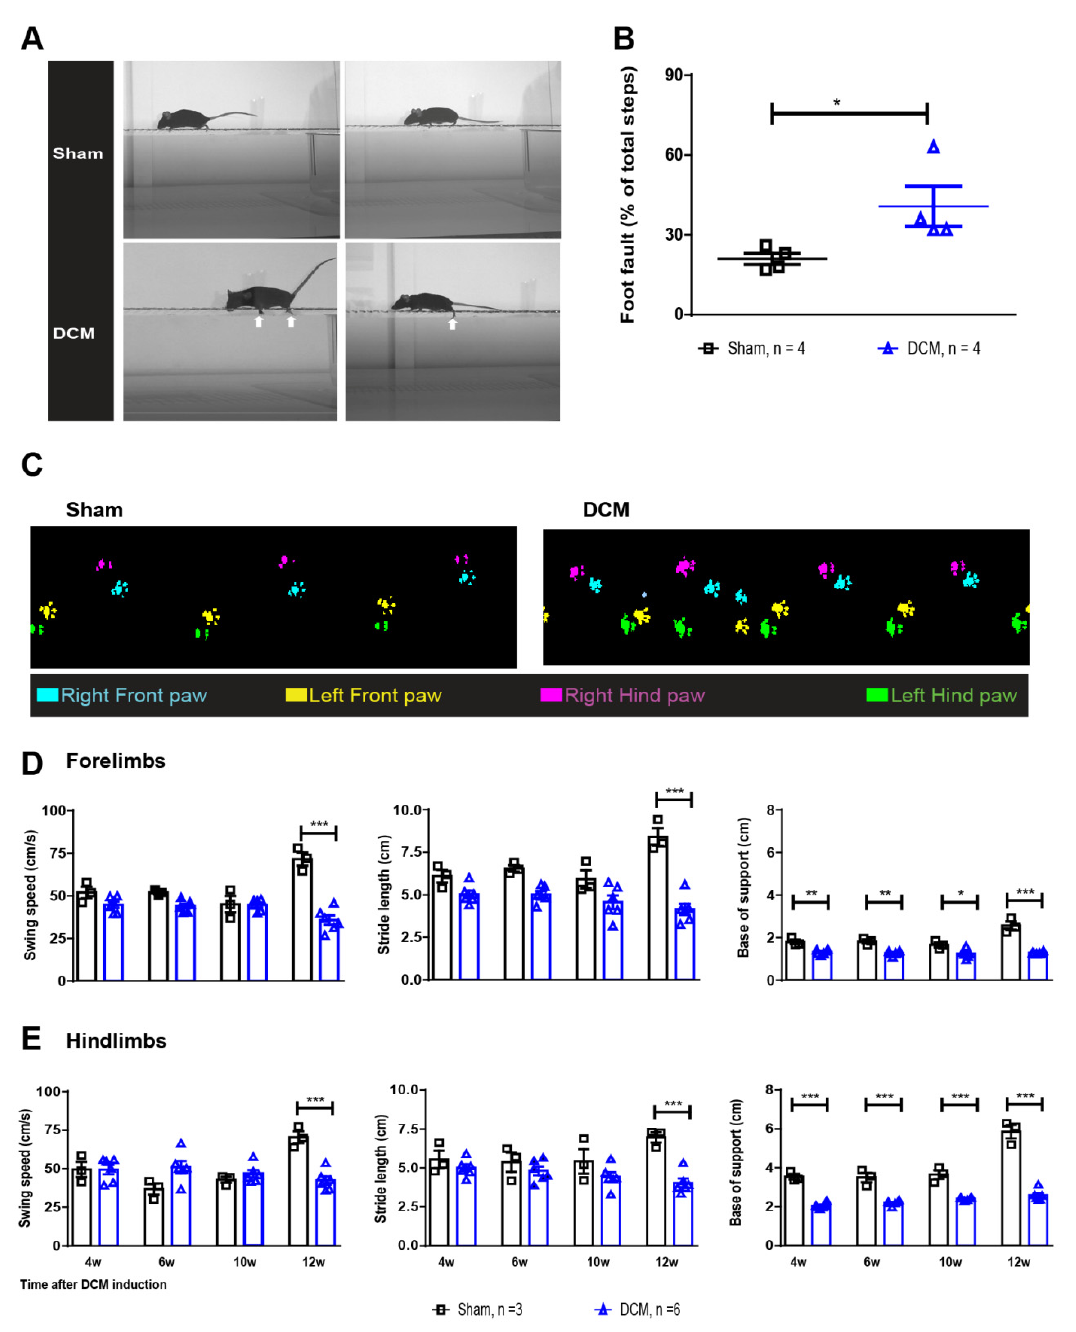
Figure 2. Neurobehavioral impairment following DCM induction in the mouse model. ( A ). Representative images of sham and DCM animals performing the horizontal ladder walk test at 12 weeks post-DCM induction. The arrows represent foot fault in fore- and hindlimbs. ( B ) The average percent (%) foot faults were significantly increased in the DCM group compared with the sham group (* p < 0.05, Mann-Whitney U test). Sham = (week 12) = 4; DCM = (week 12) = 4. ( C ) Representative CatWalk footprints from sham and DCM mice. ( D , E ) CatWalk results showed a significant decrease in both forelimb and hindlimb overground locomotion. Swing speed and stride length were impaired at 12 weeks after DCM-induction (*** p < 0.001, Two-Way ANOVA, Tukey post-hoc), whereas base support deterioration was observed from week 4 onward (* p < 0.05; ** p < 0.01; *** p < 0.001, Two-Way ANOVA, Tukey post-hoc). Data are presented as mean ± SEM.